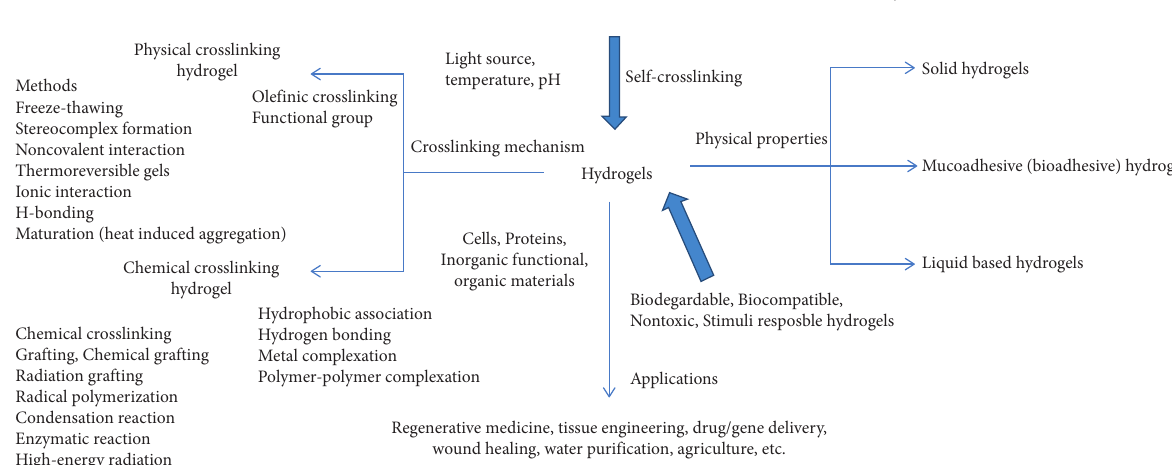
Figure 2: Classification of polymer hydrogels (adapted from